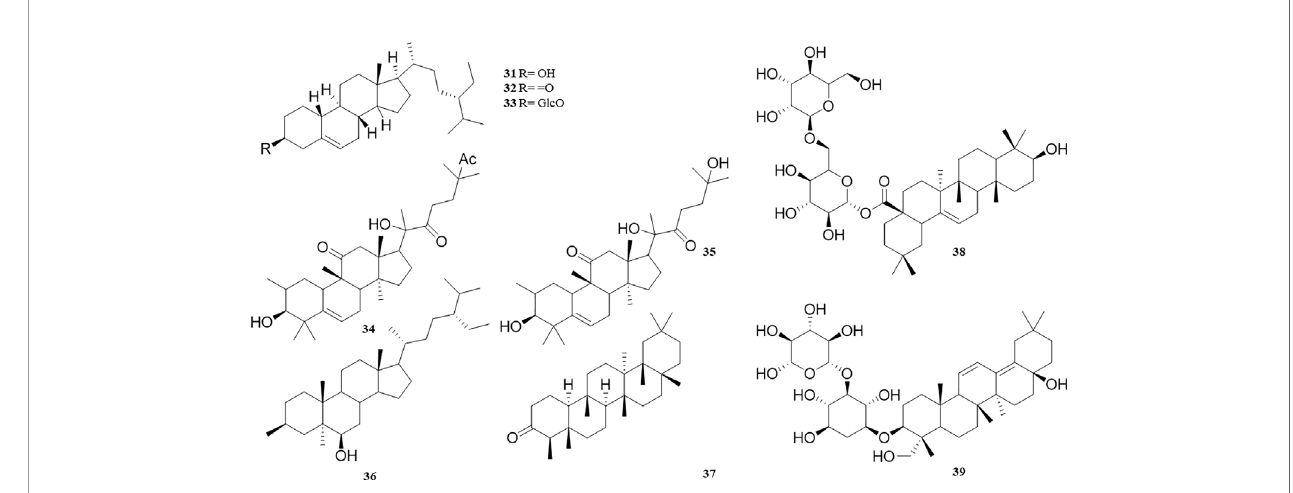
FIGURE 4 | Structure of Terpenoids from P. perfoliatum.